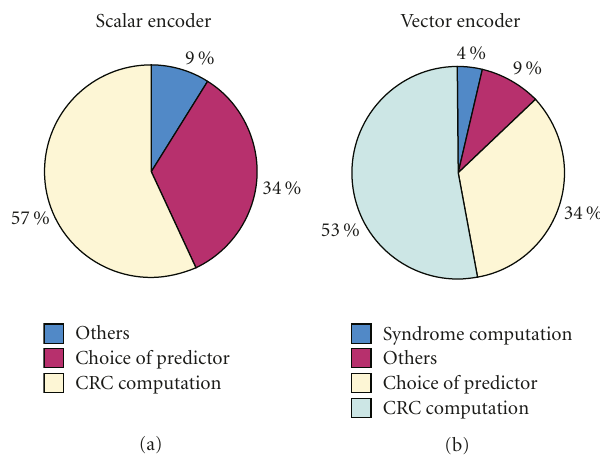
Figure 5: Computational complexity of the scalar and vector en- coders split among